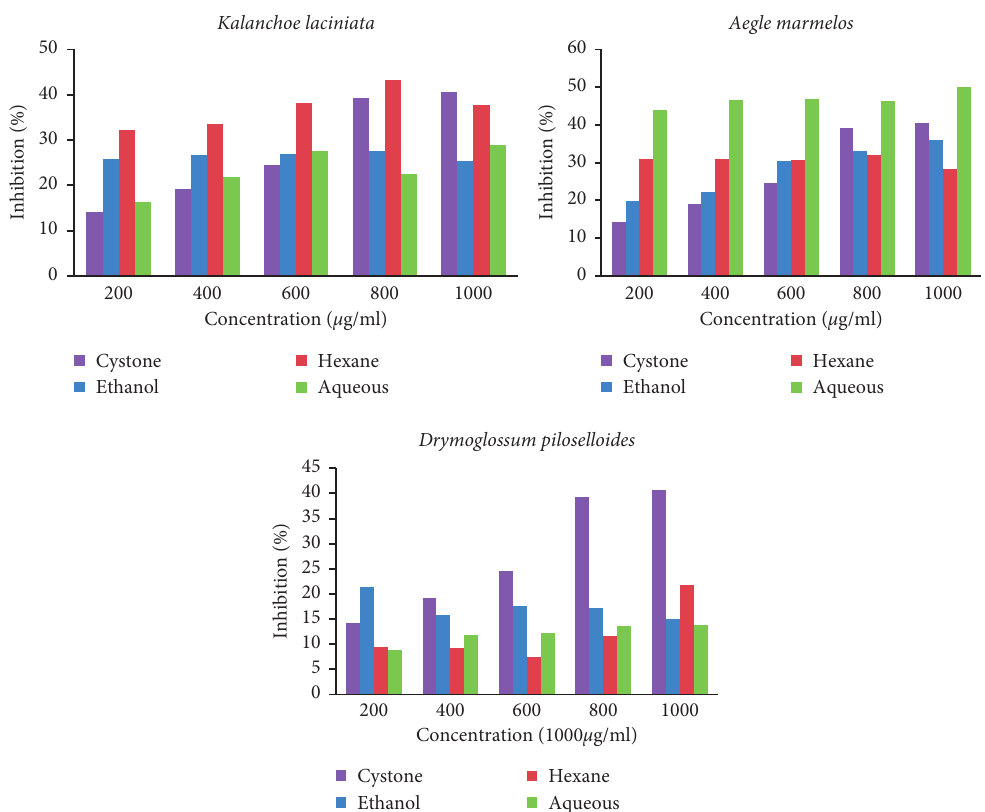
Figure 6: Percentage of inhibition of different extracts on CaOx crystals aggregation. Each graph shows the dose response effect of each plant extracted in ethanol, hexane, and water against the standard drug, Cystone. No significant difference in inhibition ( p > 0.05) was observed between ethanol (at 600 μ g/mL), hexane (at 800 μ g/mL and 1000 μ g/mL), and aqueous (at 200 μ g/mL, 400 μ g/mL, and 600 μ g/mL) extracts of Kalanchoe laciniata , ethanol extract of Aegle marmelos (at 400 μ g/mL and 1000 μ g/mL) and ethanol (at 400 μ g/mL), hexane (at 200 μ g/ml), and aqueous (at 200 μ g/mL) extracts of Drymoglossum piloselloides compared to Cystone but a significant difference in percentage inhibition ( p < 0.05) was observed in all other extracts at the concentrations shown compared to the standard